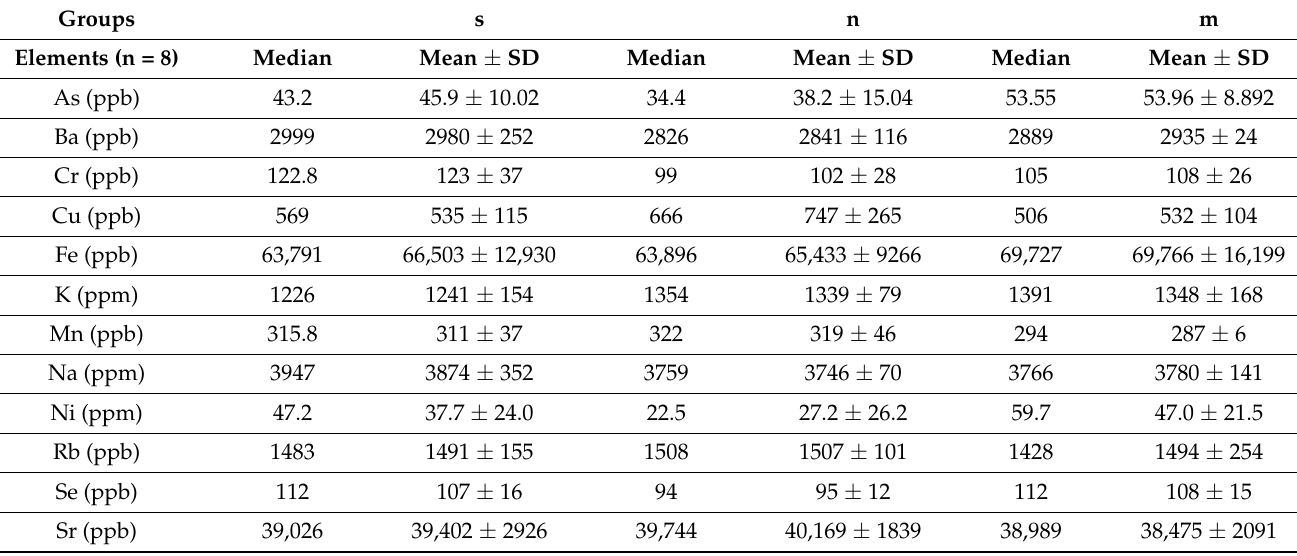
Table 3. Median, mean, and standard deviation of the elemental content in the bones of rats with cancer receiving various diets (standard, nano-, and microzinc-supplemented).